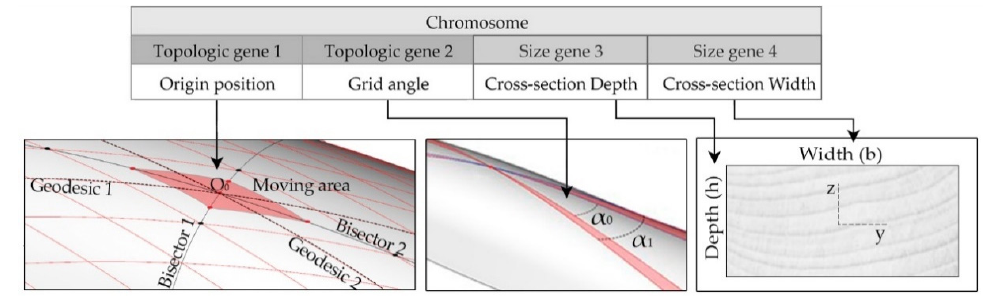
Figure 17. Solution vector composition (chromosome’s genes).